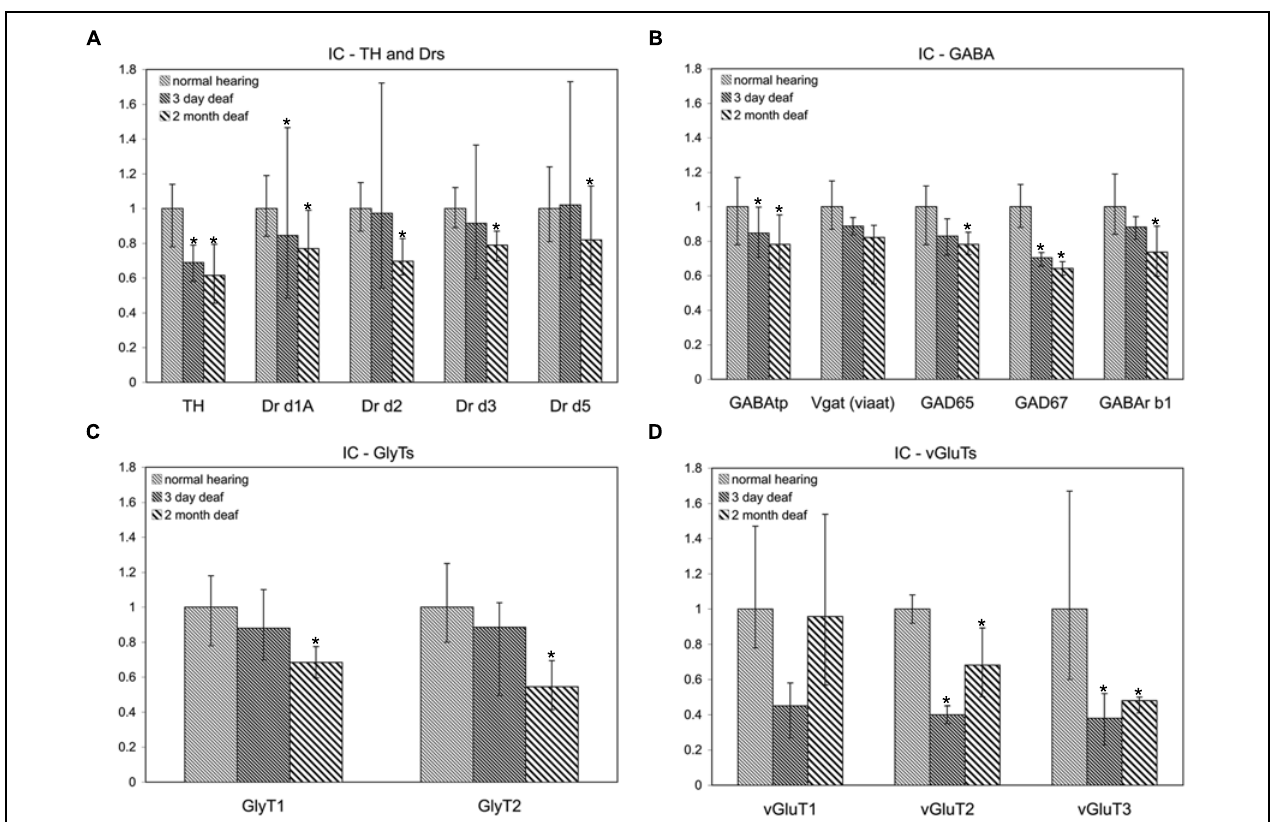
FIGURE 2 | Dopamine and AAN related genes are differentially expressed in the inferior colliculus (IC). Changes were assessed in DA related (A) , inhibitory (B,C) , and excitatory (D) AAN related gene expression in the IC 3 days and 2 months following bilateral cochlear ablation. TH expression decreased significantly in the IC at both 3 days (31%) and 2 months (38%). In addition to the DA receptor subunit, Drd1A (15%-3 days; 23%-2 months; A ), four AAN related genes showed the same pattern of expression as TH: significant decreases at both time